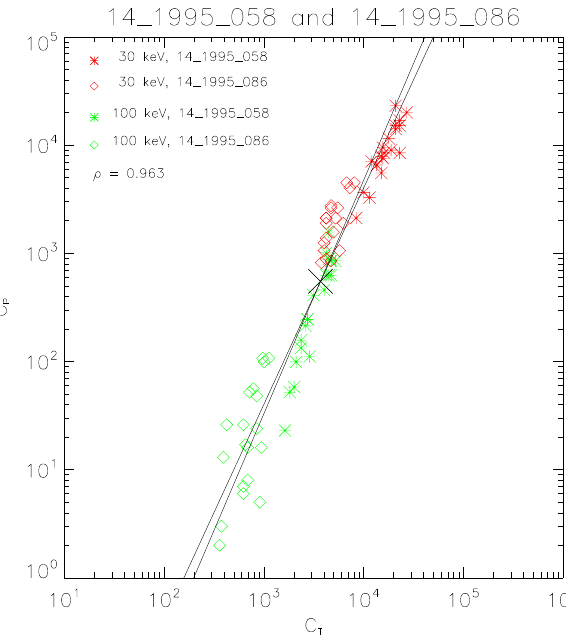
Figure 10: Precipitated against trapped count rates for ’noon’ overpasses on days February 27th and March 27th Fig. 10. Precipitated against trapped count rates for “noon” over- 1995, for both 30 keV and 100 keV populations, including regression lines. passes on days 27 February and 27 March 1995, for both 30keV and 100keV populations, including regression